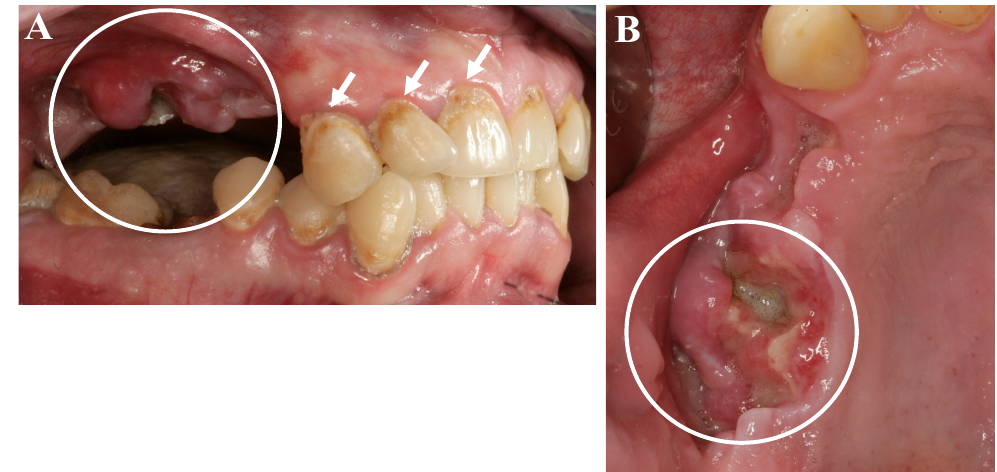
Figure 1. Oral and dental situation of a young patient after long years of methamphetamine abuse. ( A ) Characteristic cervical carious lesions (white arrows) and a severe wound healing disturbance with exposed jaw bone and a superinfection of the surrounding tissues of the maxilla (white circle), two weeks after tooth extraction alio loco ; ( B ) View on the exposed bone of the maxilla (white circle) [9].